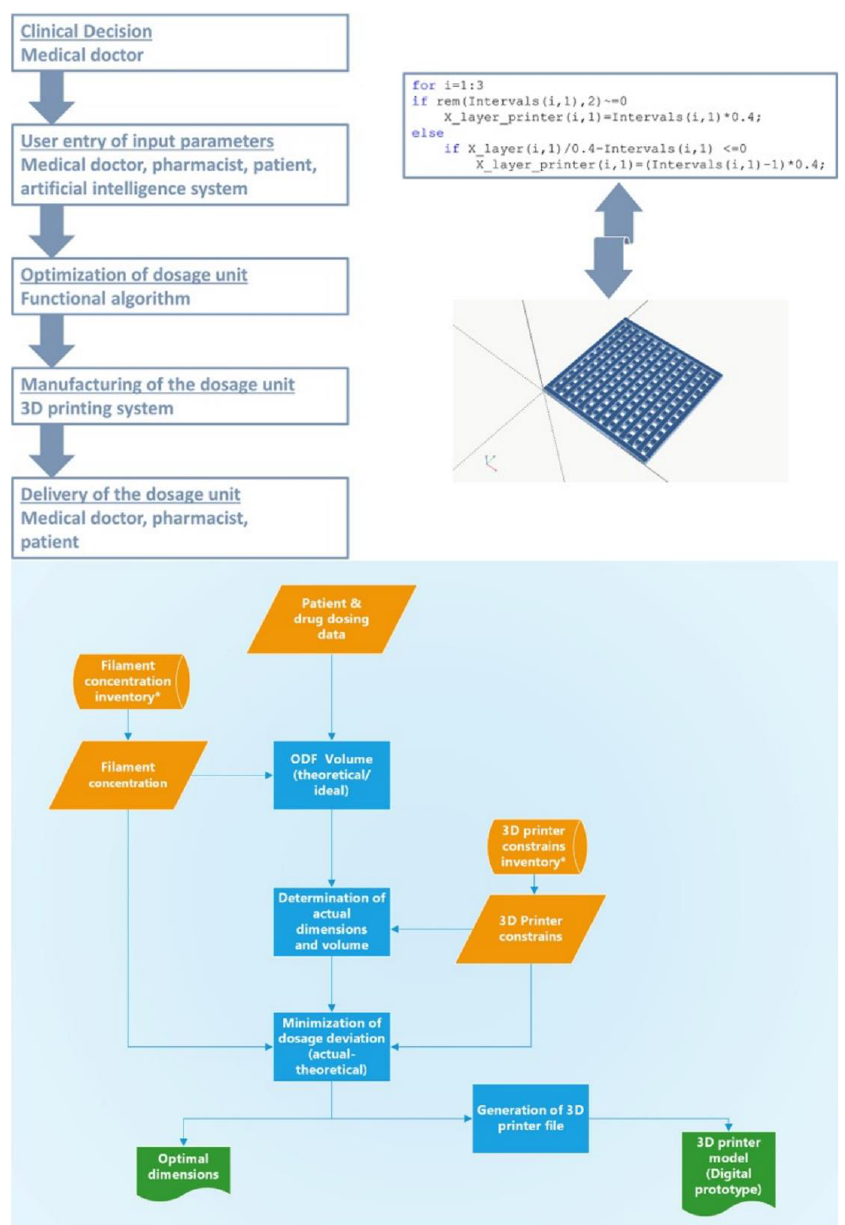
Figure 6. Example of a future scenario for automated digital design of customized medicinal products through an algorithm. The algorithm processes the appropriate input data, i.e., the suggested therapeutic plan and the available feedstock properties, and generates the optimal digital design of the medicinal product. Afterwards, the generated design can be loaded to the 3D printer by a medical doctor, a pharmacist, or a patient in order to proceed with manufacturing of a personalized dosage form [79].